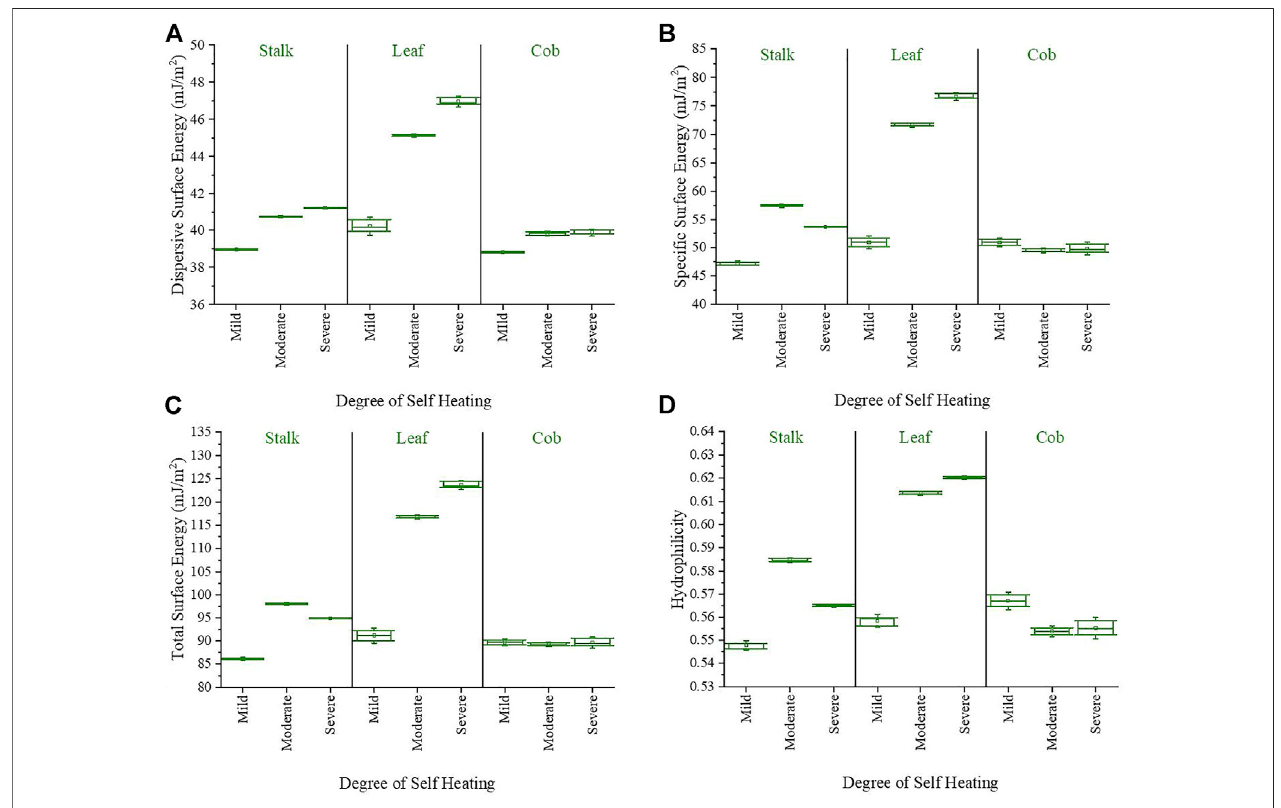
FIGURE6|(A) Dispersive, (B) speci fi c, (C) totalsurfaceenergy,and (D) hydrophilicityofcornstoveranatomicallyfractionatedsamplesfromBale5[boxupperand lower limit = data max. and min., whiskers = sample standard deviation (Coeff. 1.5), solid horizontal line = median, hollow internal box =